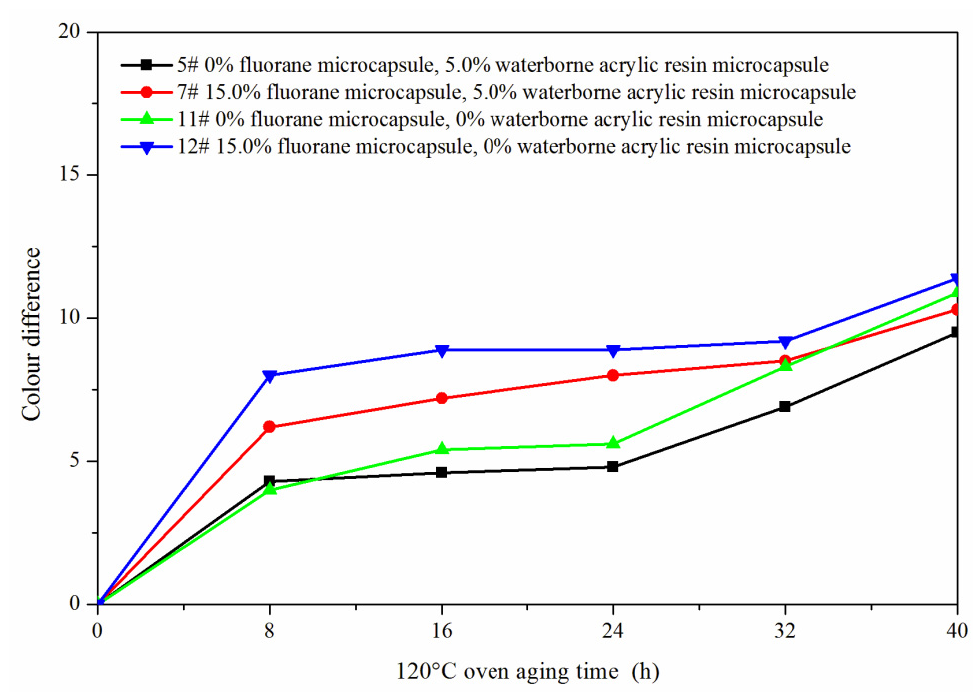
Figure 13. Effect of aging time on color difference of film at 120 °C in oven.